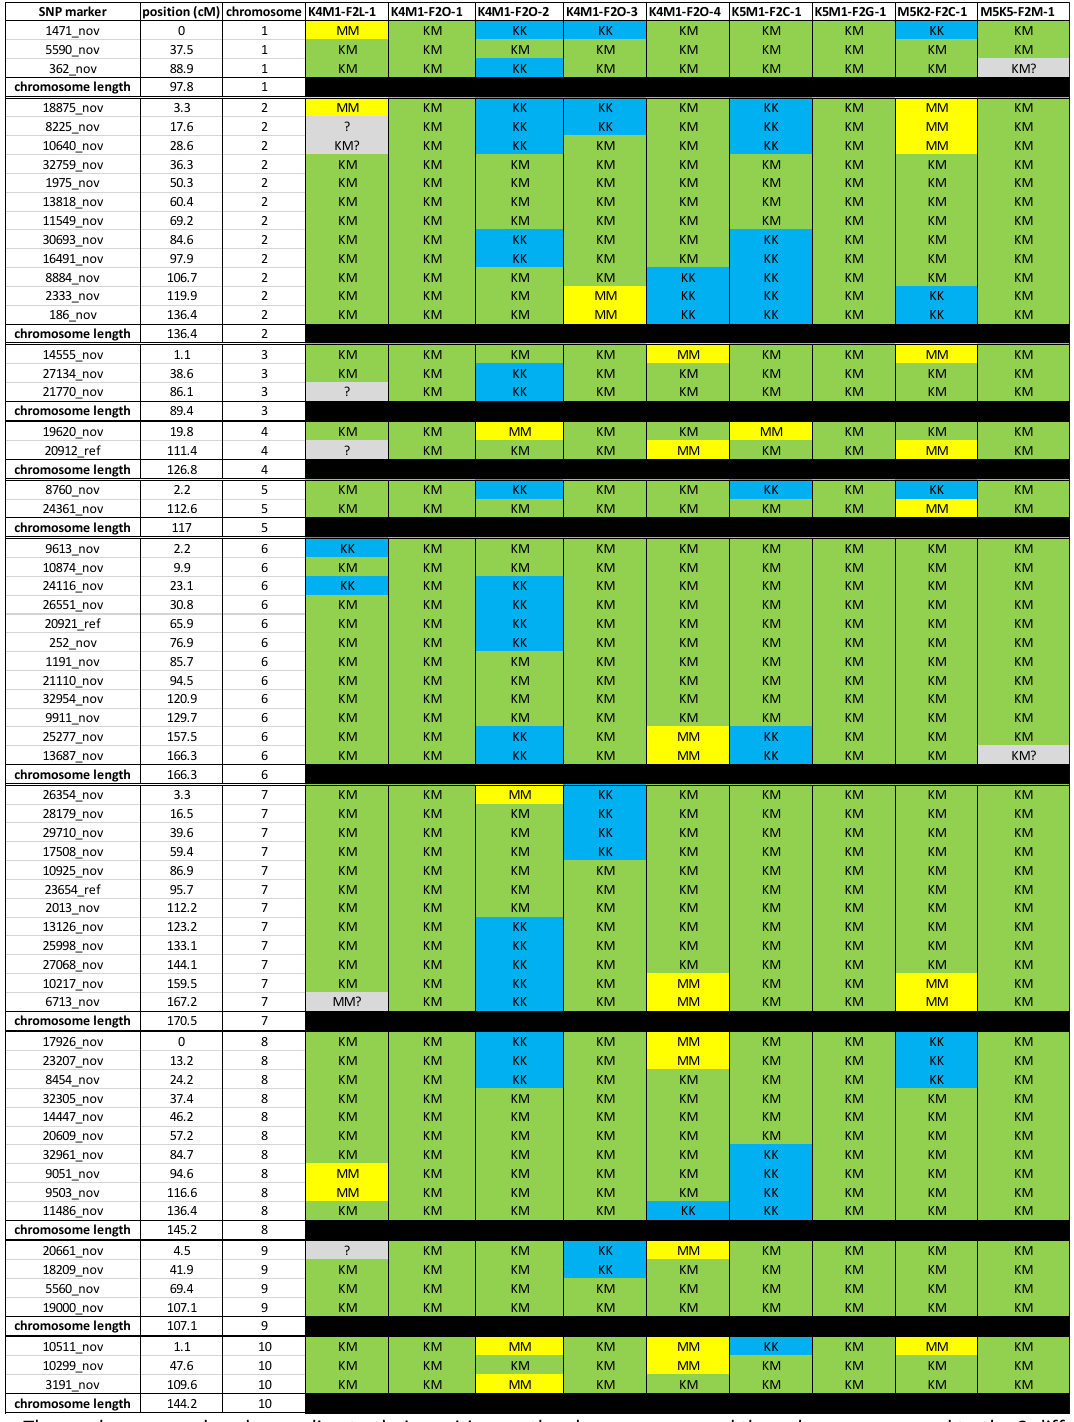
The markers are ordered according to their position on the chromosomes and the colours correspond to the 3 different possible genotypes: yellow for Makindu homozygote, green for heterozygote, and blue for Kobodo homozygote. A change of colour in a parthenogenetic daughter’s column indicates a recombination event between the two successive markers. Grey cells correspond to uncertain